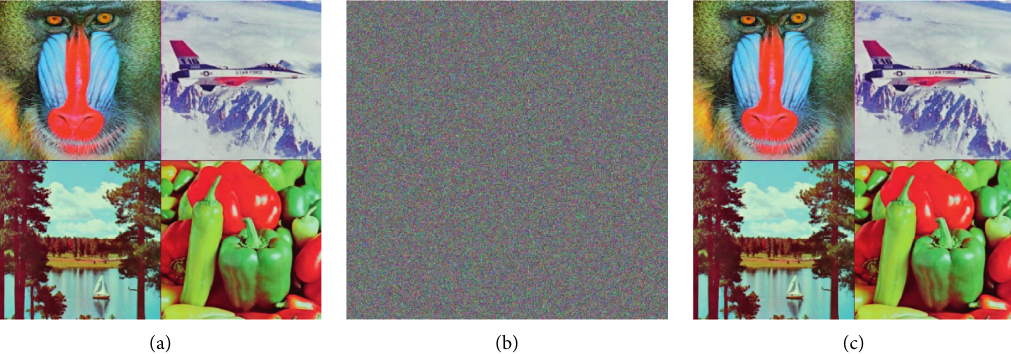
Figure 4: (a) Plain composite image (which consists of input images Ig01, Ig02, Ig03, and Ig04), (b) the cipher composite image obtained using our proposed multiple-image cryptosystem, and (c) the decrypted composite